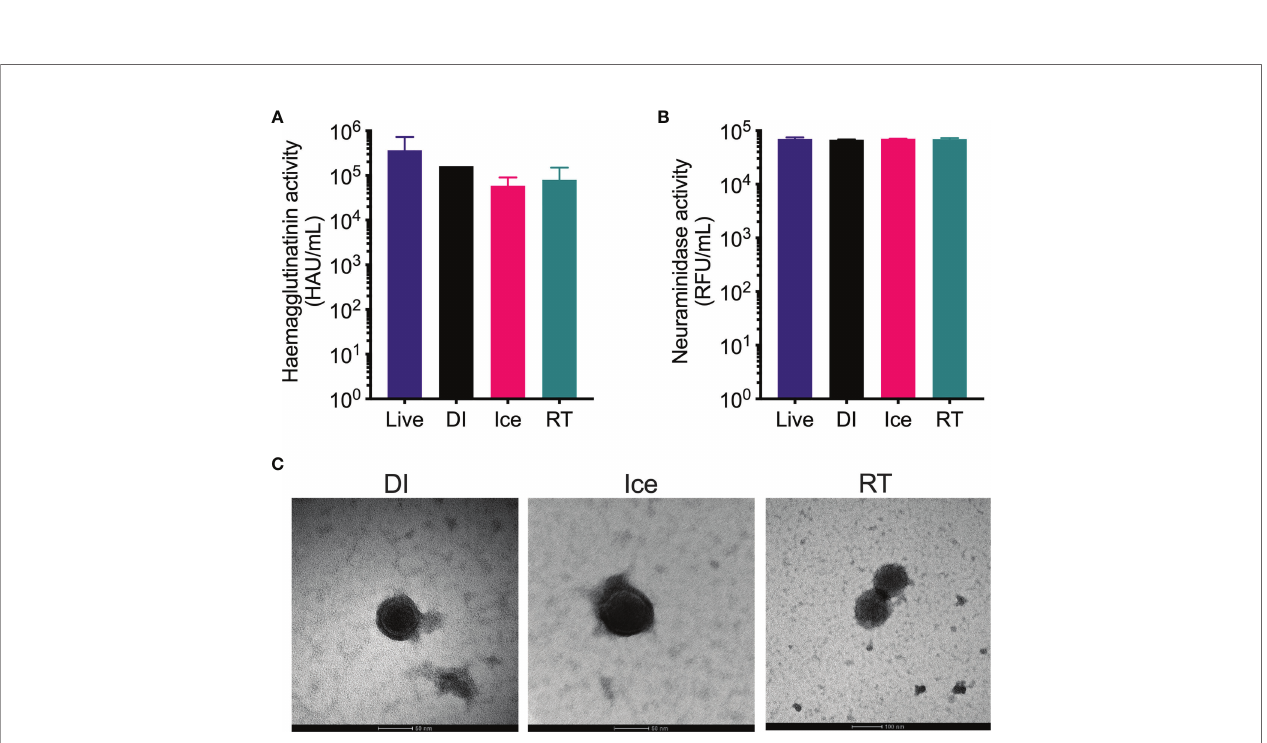
FIGURE 2 | Structural integrity of IAV is maintained after g -irradiation at different temperatures. g -Flu preparations were inactivated with either: 16 kGy at RT, 16 kGy on ice, or 35 kGy on DI. Structural integrity of these preparations was then assessed by (A) haemagglutination assay, (B) neuraminidase assay and (C) transmission electron microscopy. Quantitative data is expressed as mean ± SEM (n = 3). Data is analysed by one-way ANOVA and results were not signi fi